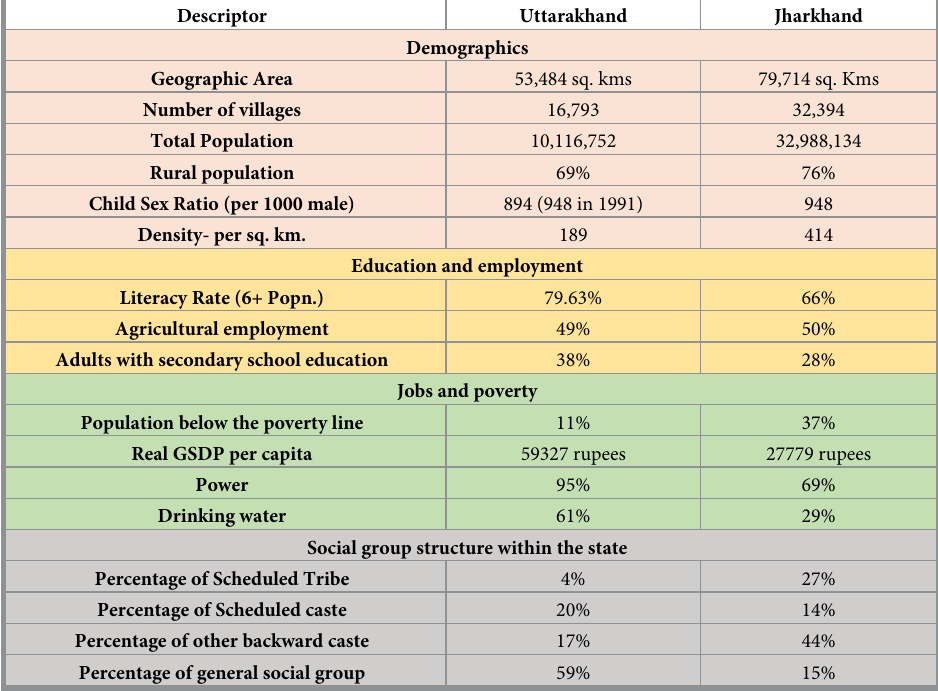
Table 1. Demographics and key indicators from Uttarakhand and Jharkhand ((Ministry of Health & Family Wel- fare, 2018; World Bank Group, 2016; Work Bank Group 2017). Descriptor Uttarakhand